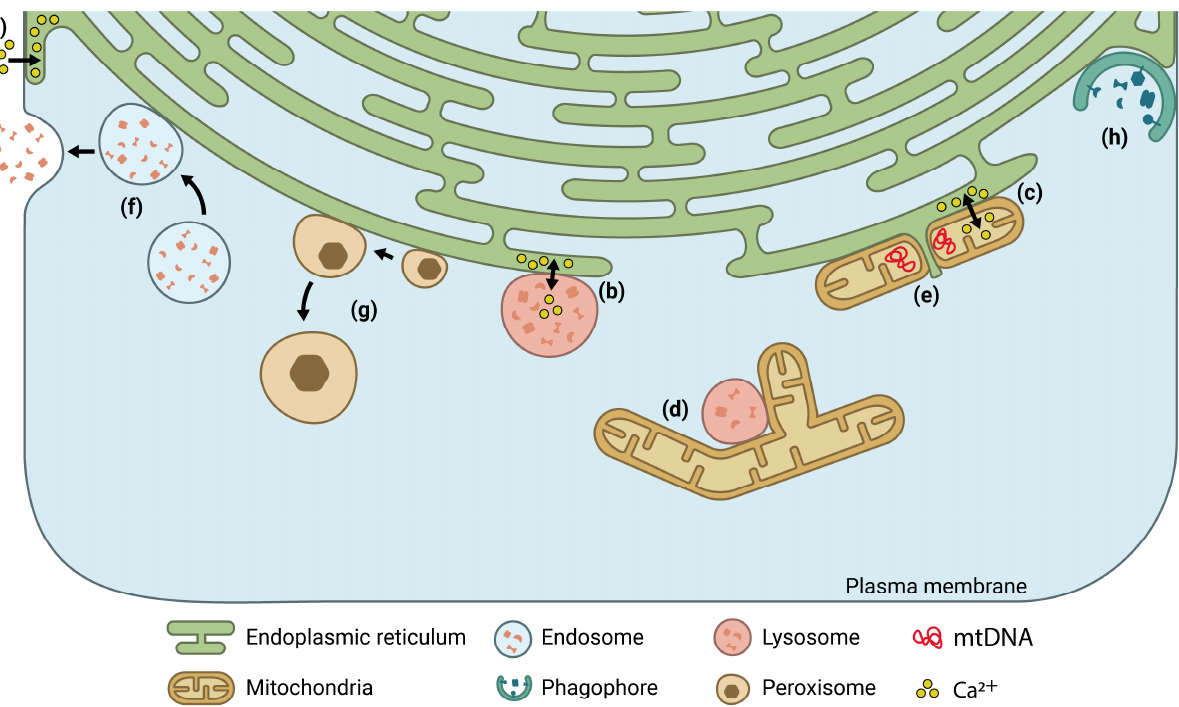
Figure 1. Schematic representation of the main MCS studied and characterized by SRFM. ( a ) ER-PM MCS regulate Ca 2+ influx from the extracellular environment to the ER in order to replenish its storage; ( b ) ER-stored Ca 2+ can then be exchanged to the lysosomes and ( c ) mitochondria through the corresponding organelle juxtapositions; ( d ) interactions between mitochondria and lysosomes have also been described; ( e ) contact sites with ER also regulate mitochondrial dynamics and morphology, and couple mtDNA synthesis and distribution with mitochondrial division; ( f ) contacts with ER allows the transport of late endosome to the PM; ( g ) ER-peroxisome droplet MCS regulate peroxisome growth, cholesterol homeostasis, and the synthesis of plasmalogens; ( h ) biogenesis of autophagosome commence at the ER-PM MCS.